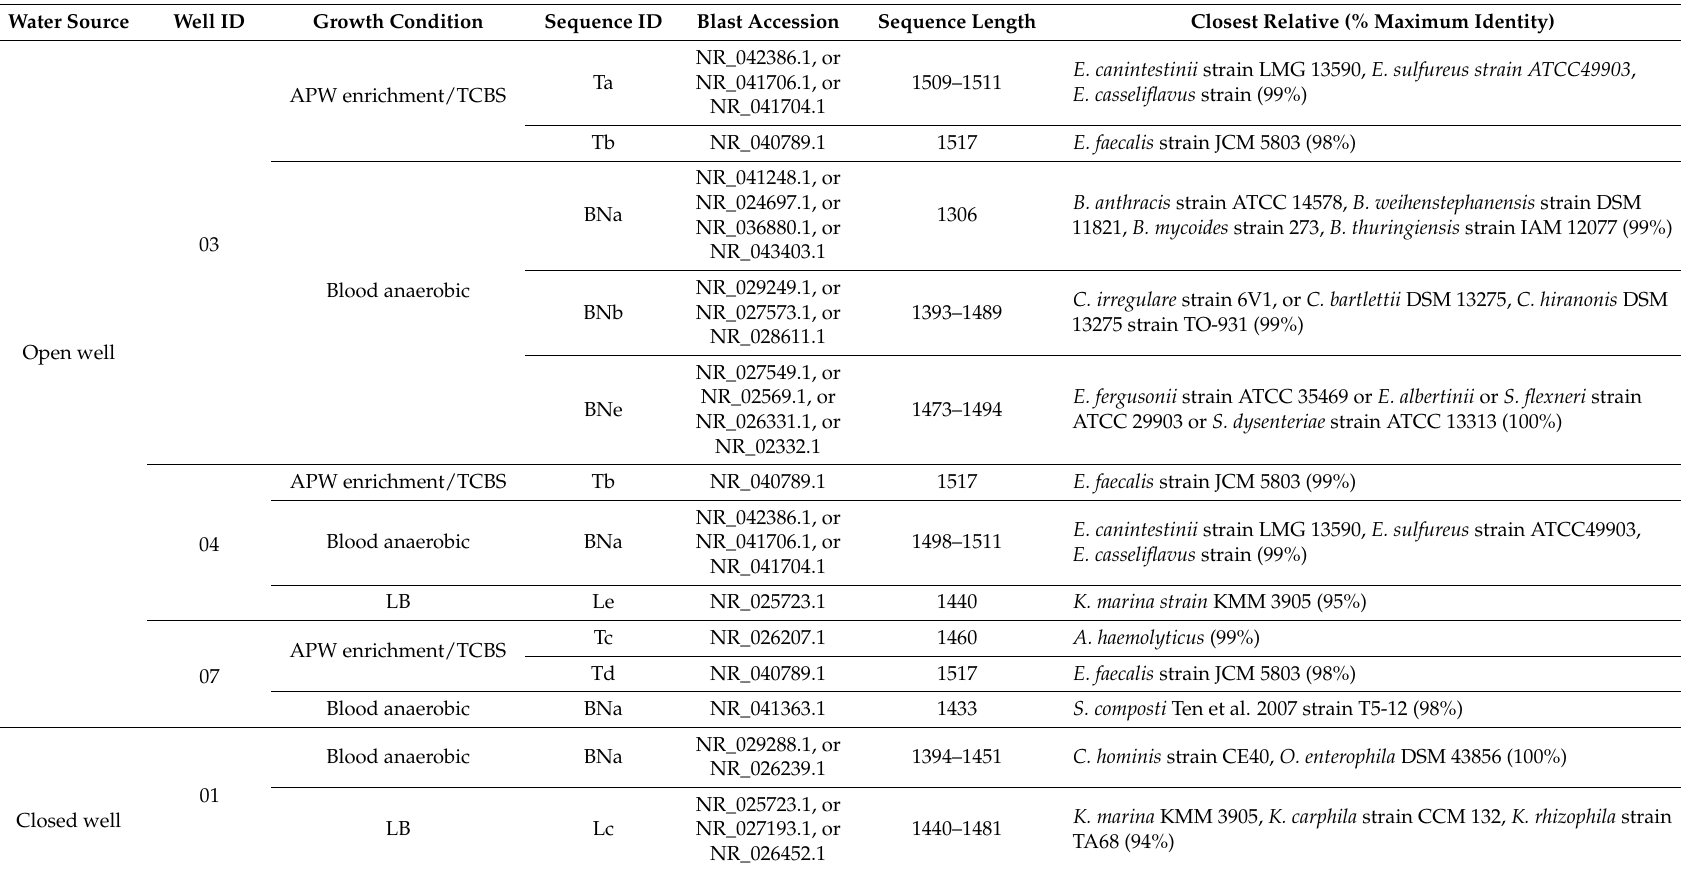
Table 2. Sequence results for cultured bacteria identified as pathogens or potential